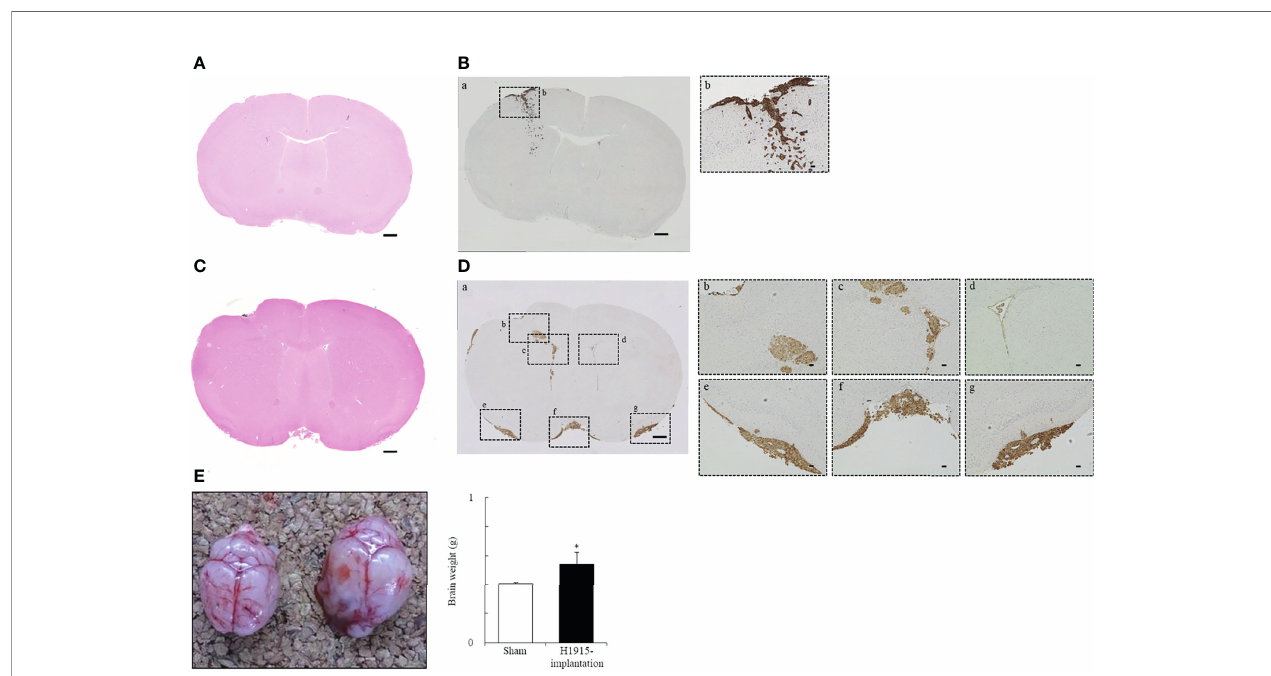
FIGURE 2 | Representative morphological features of tumor cell lines following implantation. (A – D) Histological and (E) macroscopic images of the brains. Intracranial injection of DU 145 (A, B) and H1915 (C, D) cells into nude mice shows characteristic tumor growth patterns in brain on day 14. Representative H&E- stained (A, C) and cytokeratin (AE1/AE3)-stained (Ba, Da) sections are shown (scale bar = 500 m m). Boxed areas in panels (Ba) and (Da) show regions depicted in panels (Bb) and (Db-g) , respectively. Cytokeratin (AE1/AE3) were used to distinguish brain tissues from metastatic DU 145 (Bb) and H1915 (Db-g) tumors; scale bar = 50 m m. (E) Gross features of representative brains excised from sham-operated (left; n = 5) and H1915-implanted (right; n = 4) mice on day 21. * p < 0.05 versus the sham-operated